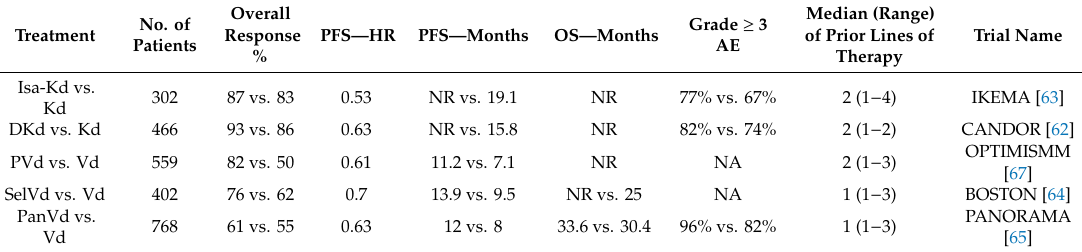
Table 4. Recent lenalidomide-free randomized trials in RRMM.